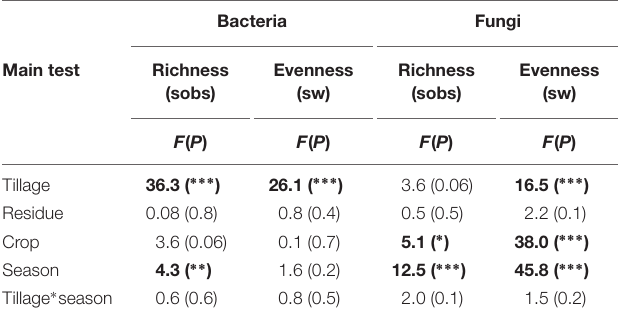
TABLE 3 | Effects of tillage regime, crop residue management, crop, and growing season on bacterial and fungal α -diversity. Bacteria